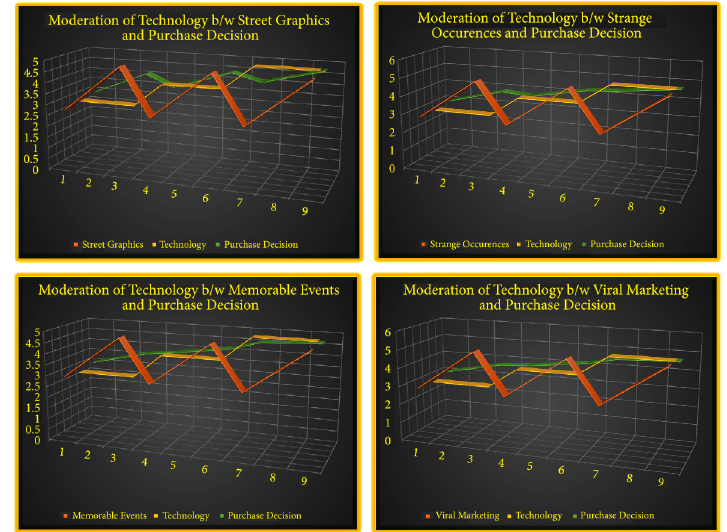
Figure 3. The visualizing conditional effect of moderator